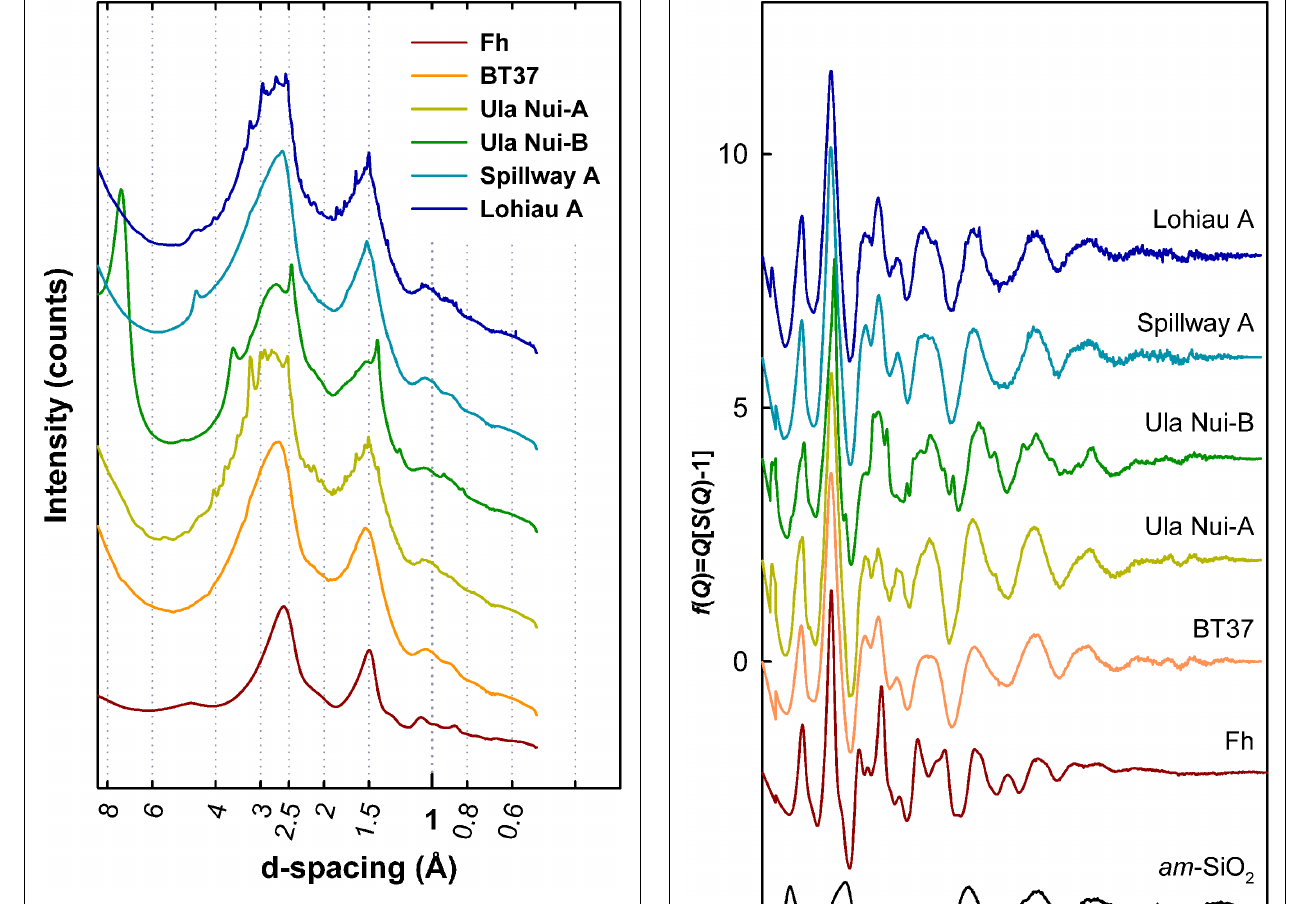
FIGURE 3 | Comparison of the synchrotron radiation X-ray diffraction plotted as d -spacing versus intensity. Two broad features characteristic of two-line ferrihydrite (Fh, bottom) occur in all samples at ∼ 1.5 and 2.55Å. The most significant impurity phase appears in Ula Nui-B and can be indexed as birnessite, a layered Mn 3 + /4 + (hydr)oxide. Sharp peaks indicating the presence of trace impurities suspected as alumino-silicate phases are also observed in Ula Nui-A, Spillway A, and Lohiau A but could not be positively identified. Increasing background intensity at d -spacings greater than ∼ 6Å due to effects of small angle scattering. FIGURE 4 | Reduced structure functions for references of Fh and